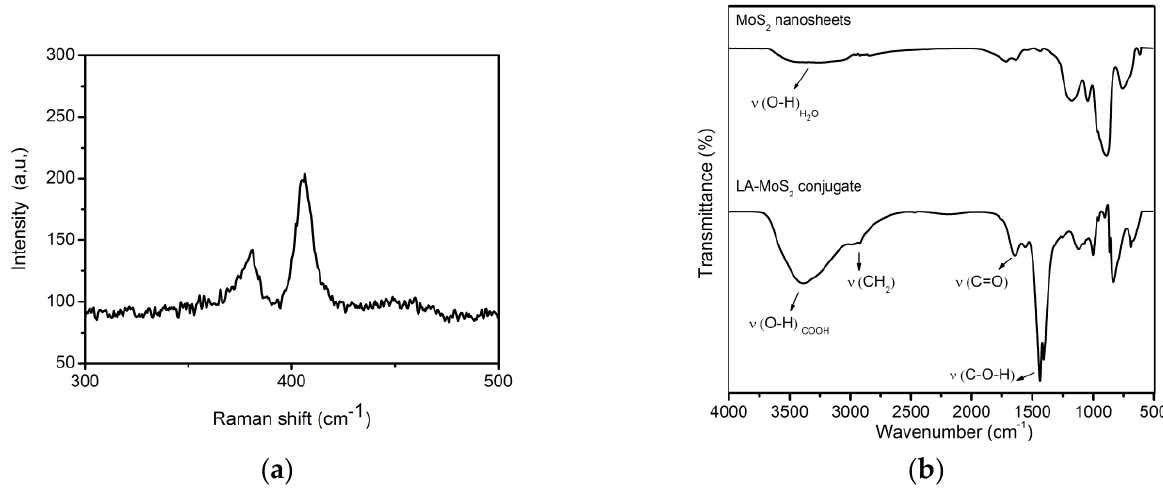
Figure 1. Spectroscopic characterization of MoS 2 and LA–MoS 2 : ( a ) Spectrum of MoS 2 after hydrothermal synthesis; ( b ) FTIR spectra of MoS 2 nanosheets and LA–MoS 2 conjugate.